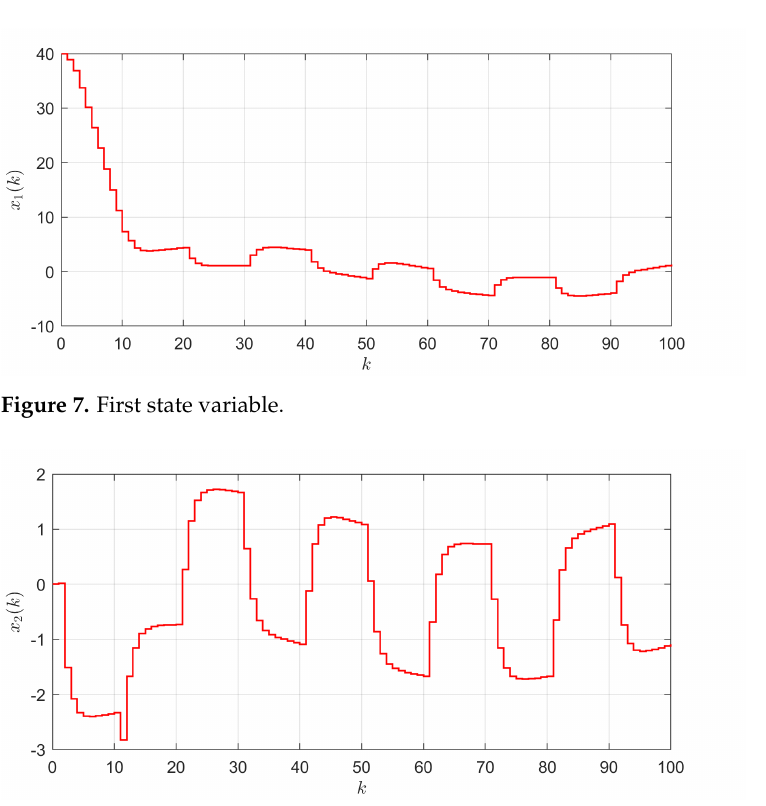
Figure 8. Second state variable.